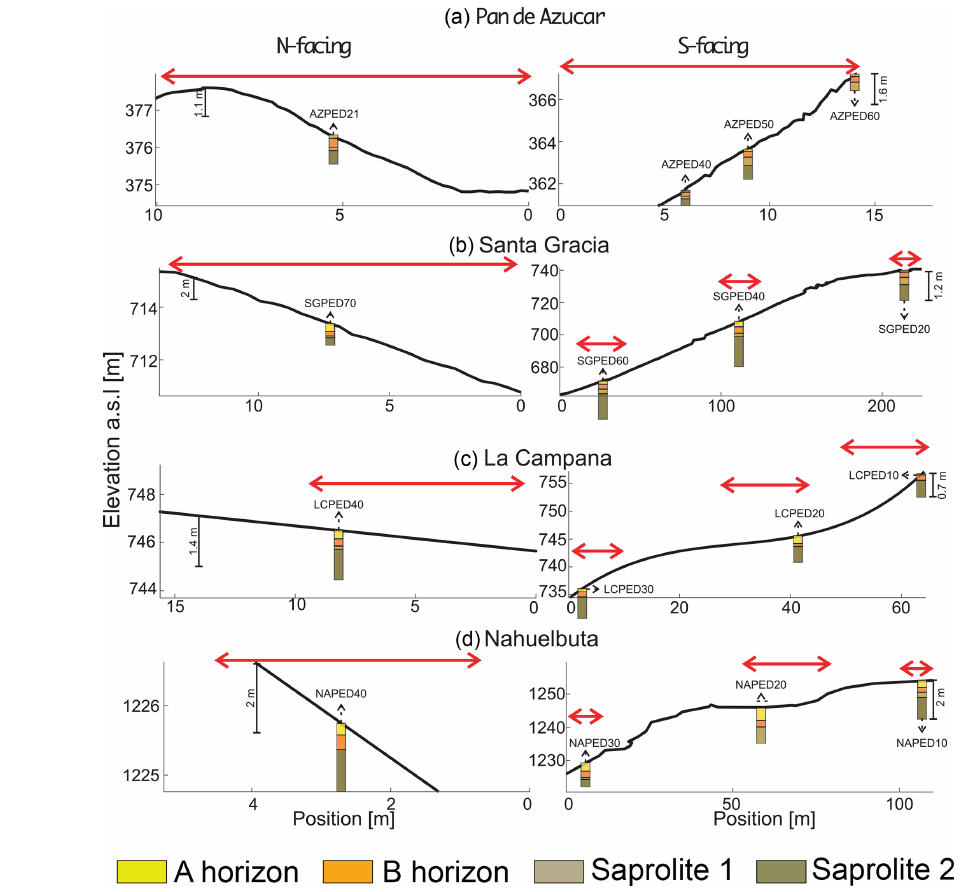
Figure 3. N- and S-facing hillslopes of the four study areas with locations of pedons and transects of ground-penetrating radar indicated by the red double arrows. For complete characterization and interpretation of the pedons, see Fig. 2 in Bernhard et al. (2018) and Figs. 3 to 6 in Oeser et al.